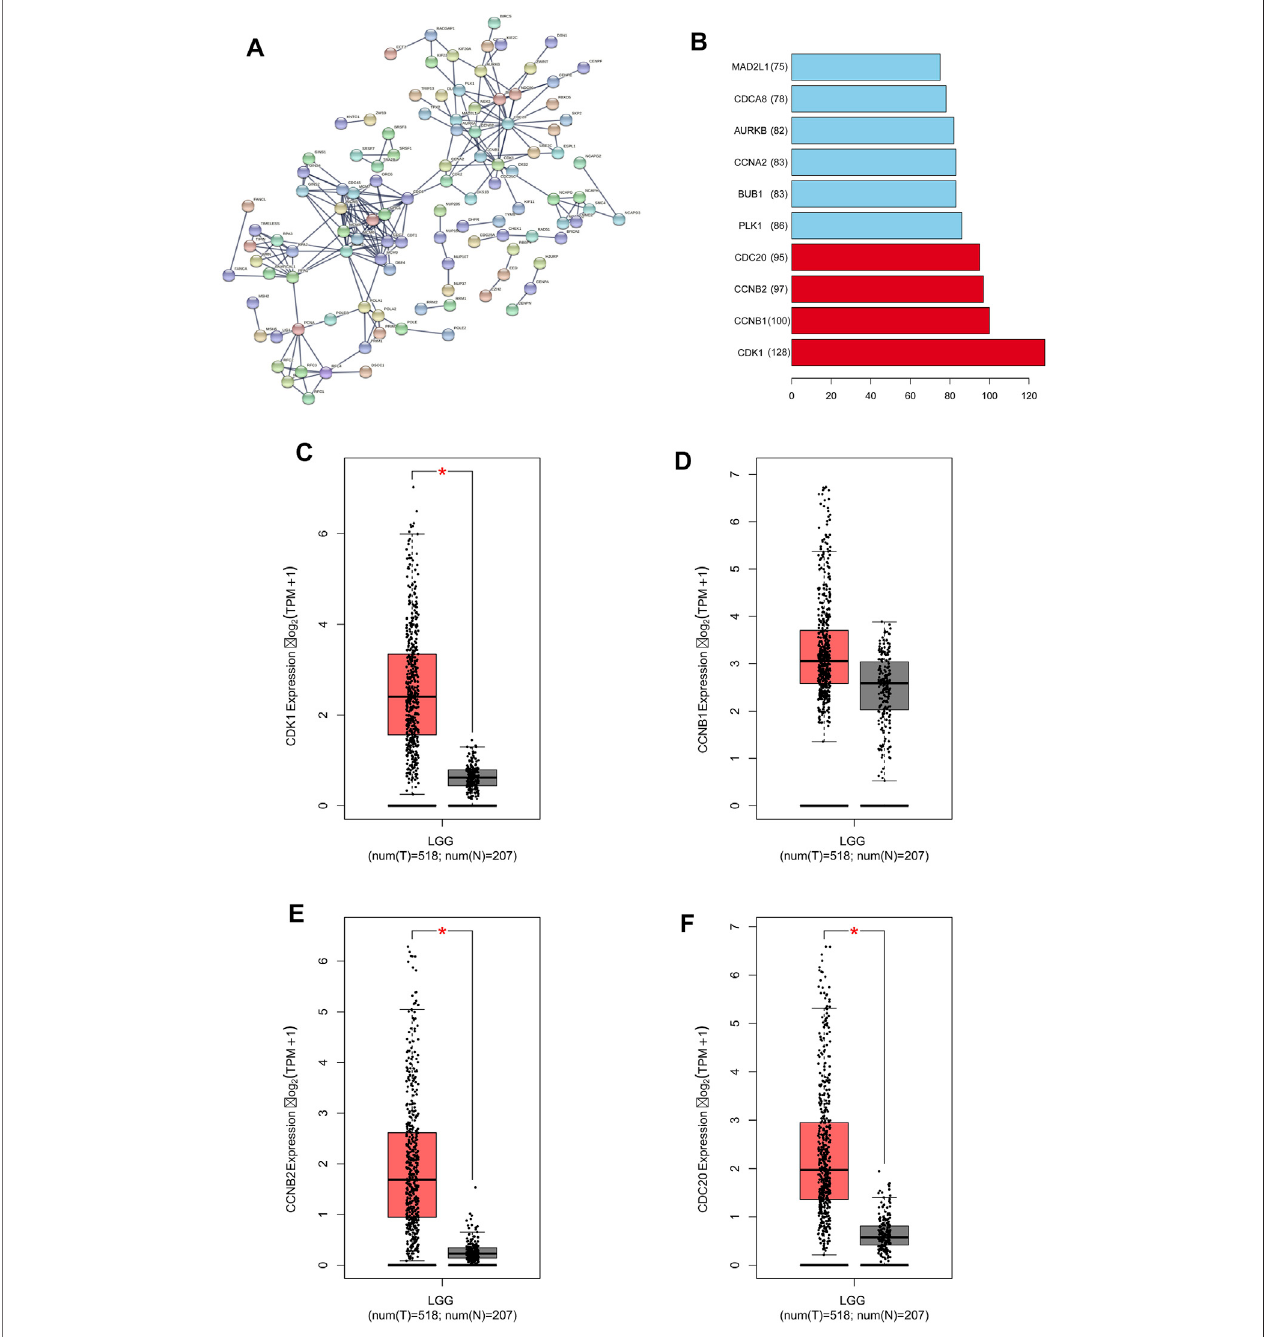
FIGURE6| C1ORF112anditsco-expressedgenesinaprotein-proteininteractionnetworkinlow-gradegliomas. (A) PPInetwork. (B) Top10ofkeyco-expressed genes of C1ORF112. The expression level of key co-expressed genes in LGGs was : (C) CDK1; (D) CCNB1; (E) CCNB2; (F) CDC20. * p < 0 .05.